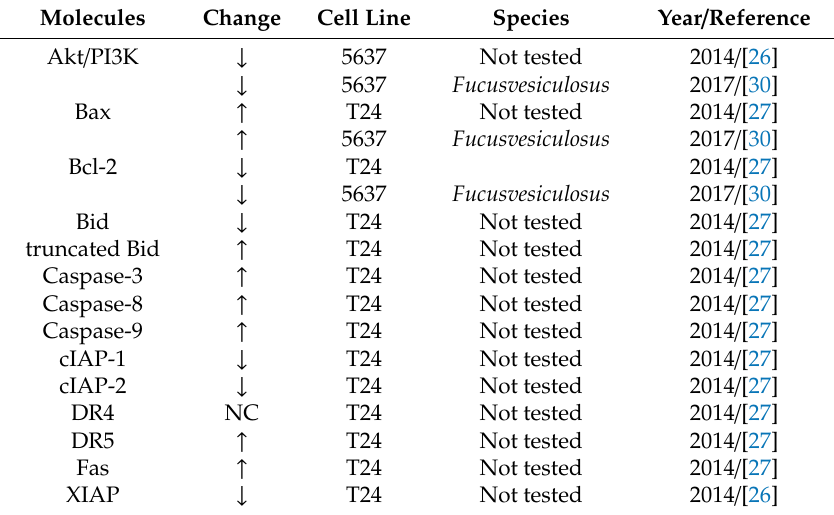
PI3K: phosphoinositide 3-kinase, Bax: Bcl-2 associated protein, Bcl-2: B-cell lymphoma 2, Bid: BH3 interacting domain death agonist, cIAP: cellular inhibitor of apoptosis, DR: death receptor, XIAP: X-chromosome-linked inhibitor of